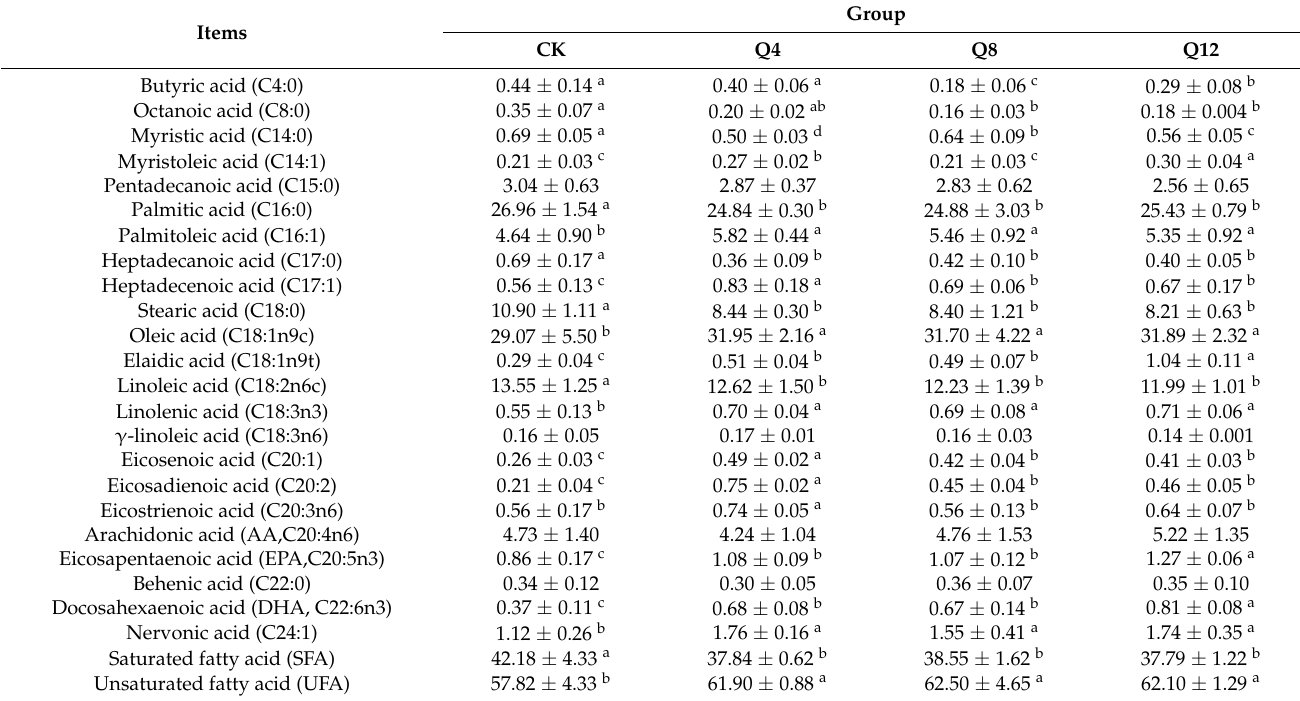
Table 2. Effect of quinoa on composition and content of fatty acids in breast muscle of female Luhua chicken